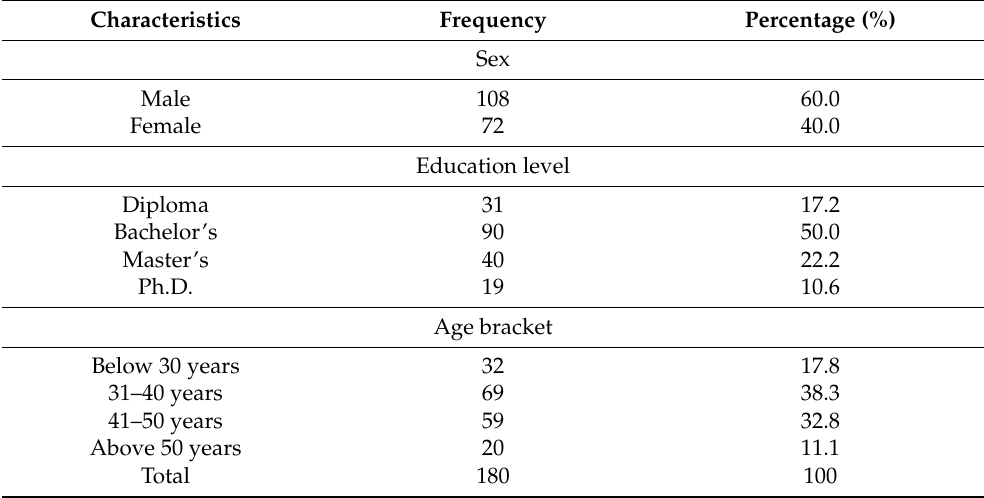
Table 3. Showing demographic data of participants.